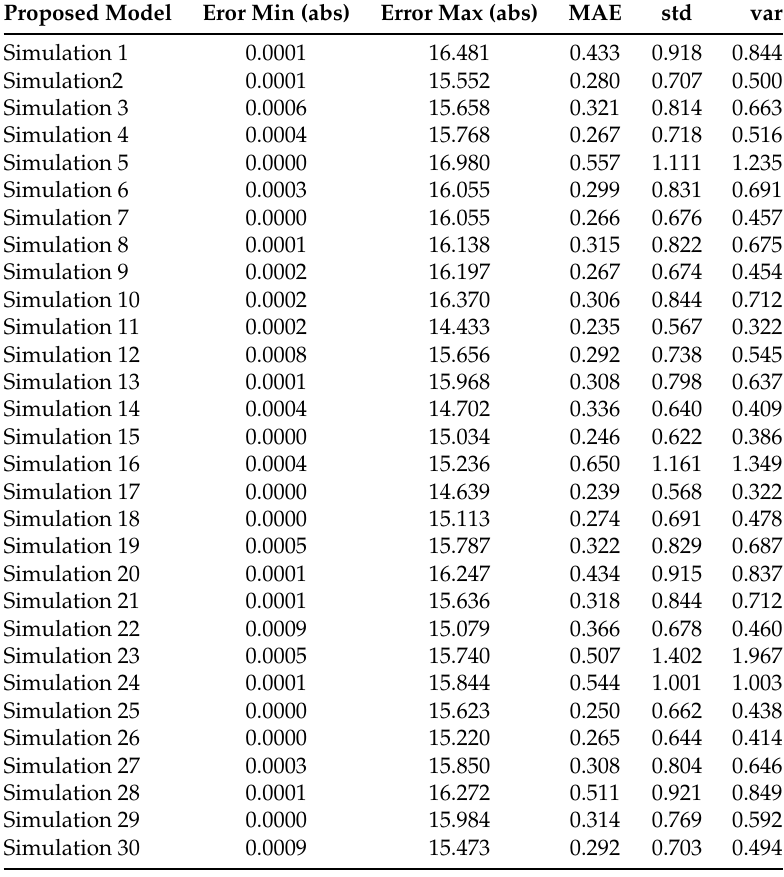
Table 4. NN model simulation summary.